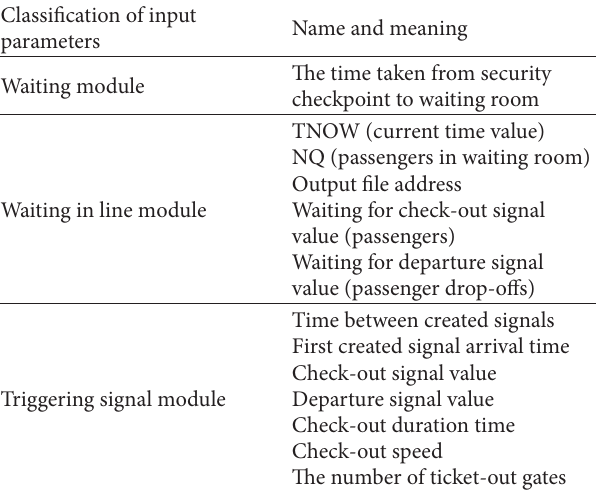
Table 2: List of input parameters used in arrival, check-in, and security check module.